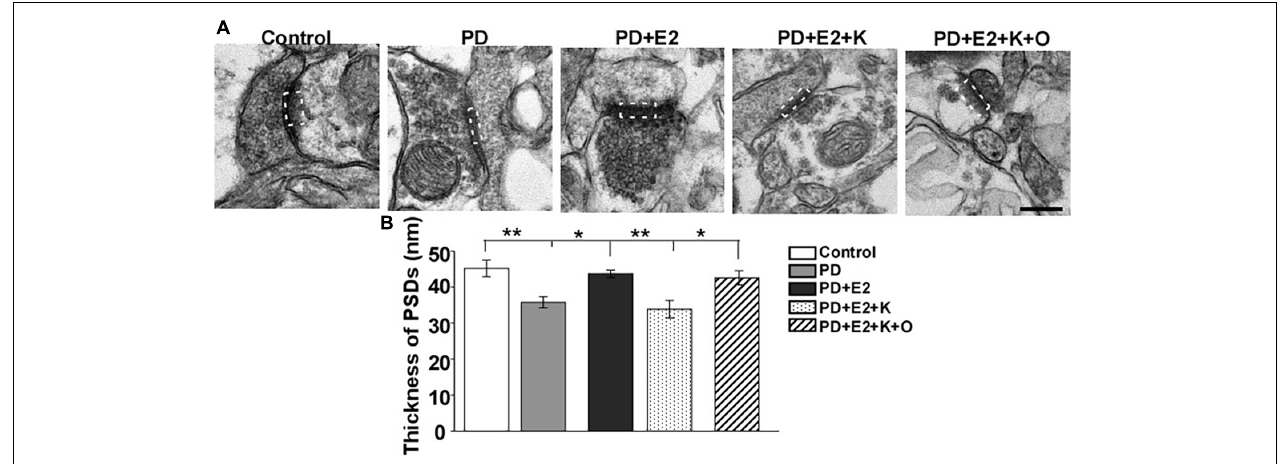
FIGURE 5 | (A) Electron micrographs and histograms (B) showing the changes in the thickness of PSD in the hippocampus in all experimental groups. The dotted box indicated the postsynaptic dense area ( n = 3, each group). Results are presented as mean ± SEM. * p < 0.05; ** p < 0.01. Scale bar = 250 nm.